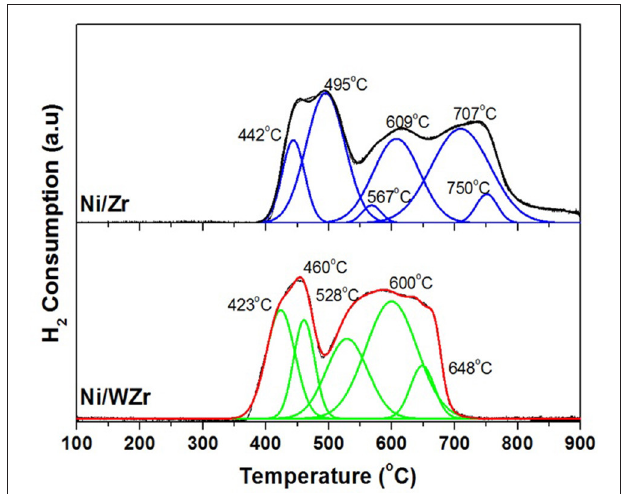
FIGURE 4 | TPR profiles of both catalysts (Catalyst mass: 100 mg, Total flow: 16mL min − 1 (1% (v/v) H 2 in He). Temperature: RT-950 ◦ C, Ramp rate: 10 ◦ C min − 1 , Main m/z fragment: H 2 = 2).